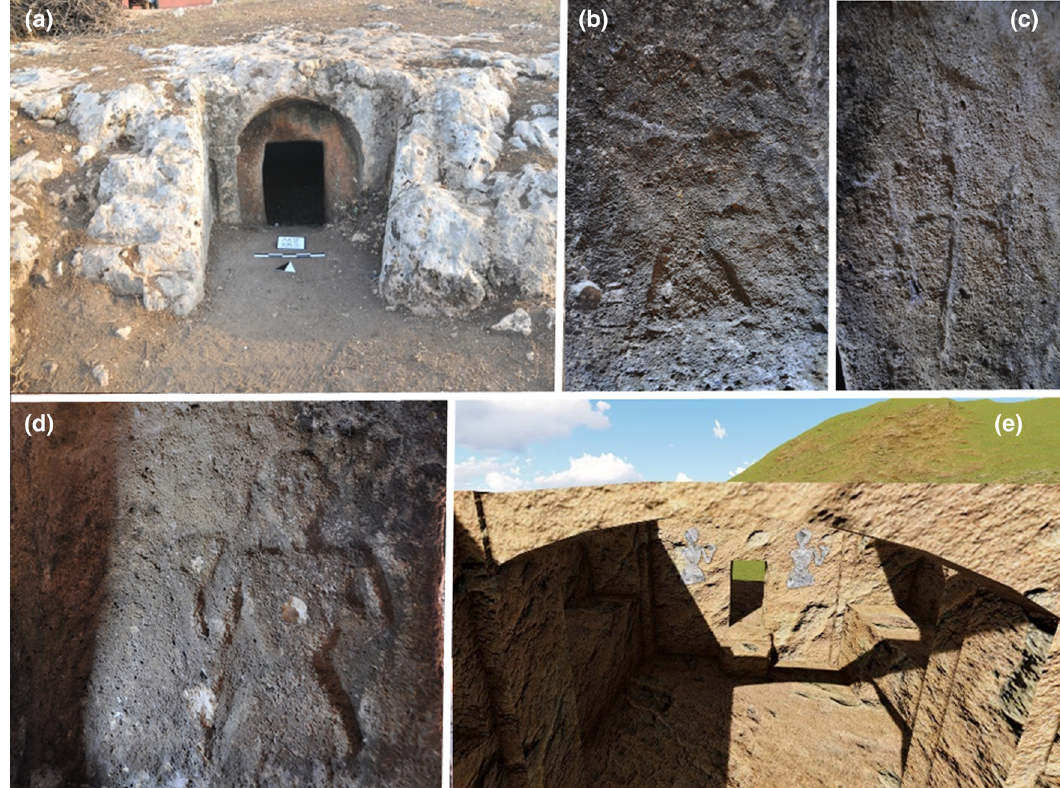
Figure 14: Rock tomb No. 3 ( a ) and anthropomorphic bas reliefs ( d ) with 3D restitution ( e ) ; motive unspeci fi ed ( b ) and Swastika ( c ) ( Ambarçay Salvage Excavation Archive )